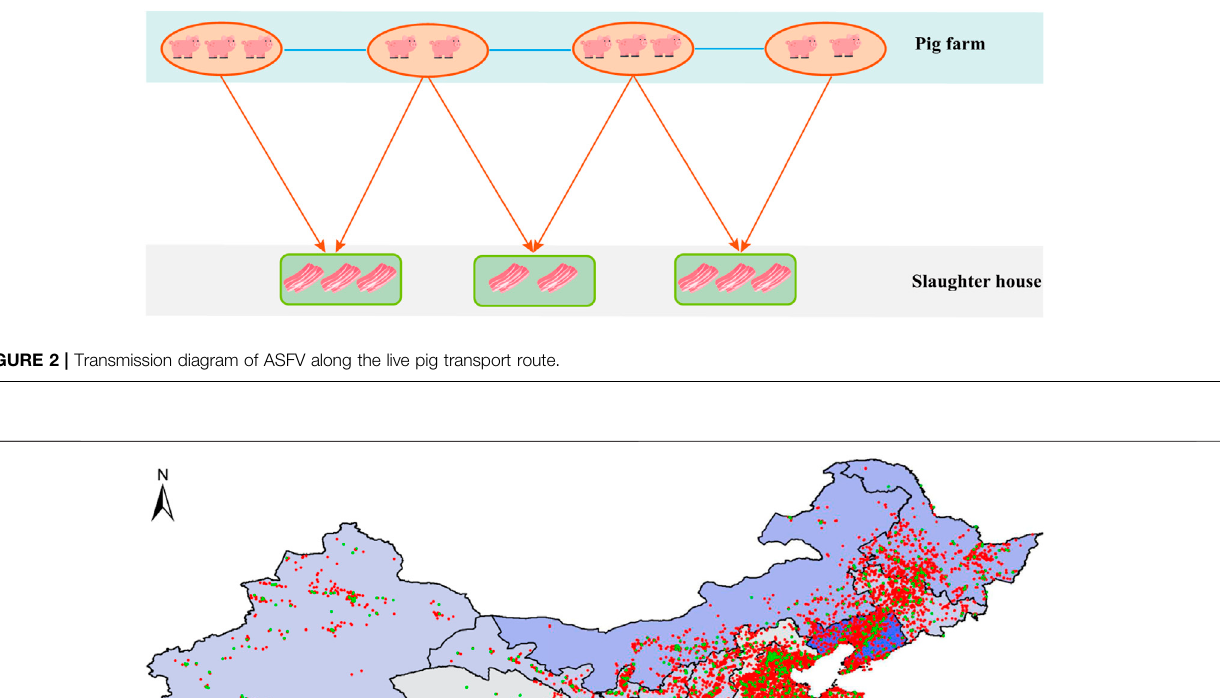
Frontiers in Physics |